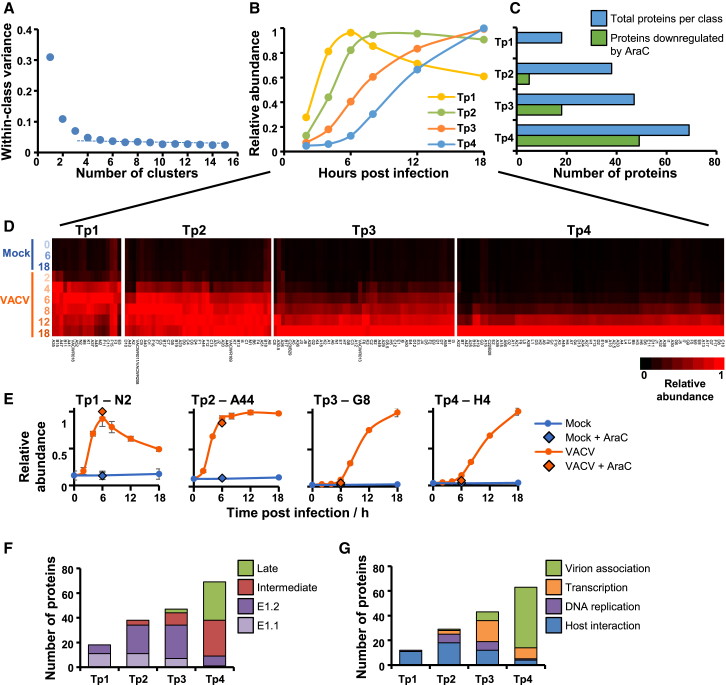
Definition of Temporal Classes of VACV Gene Expression(A) Number of temporal classes of VACV gene expression. The k-means approach was used with 1–15 classes to cluster viral proteins, and the summed distance of each protein from its cluster centroid was calculated. Although this summed distance necessarily becomes smaller as more clusters are added, the rate of decline decreases with each added group, eventually settling at a fairly constant rate of decline that reflects overfitting; clusters added prior to this point reflect the underlying structure in the temporal protein data, whereas clusters subsequently added through overfitting are not informative. The point of inflexion fell between four and six classes, suggesting that there are at least four distinct temporal protein profiles of viral protein expression.(B) Class centroid profiles.(C) Number of viral proteins per class, and the number of proteins in each class whose expression was reduced >1.5-fold by incubation with AraC (treated and untreated samples both assessed at 6 h of infection; see schematic in Figure 1A and results in Figure S3).(D) Temporal profiles of proteins in each k-means class were subjected to hierarchical clustering by Euclidian distance.(E) Temporal profiles of representative proteins from each cluster. Data are represented as mean ± SEM (n = 3).(F) Comparison of viral protein and transcript classes.(G) Functional analysis of viral proteins, based on information from Yang et al. (2010) and other references detailed in Table S5.